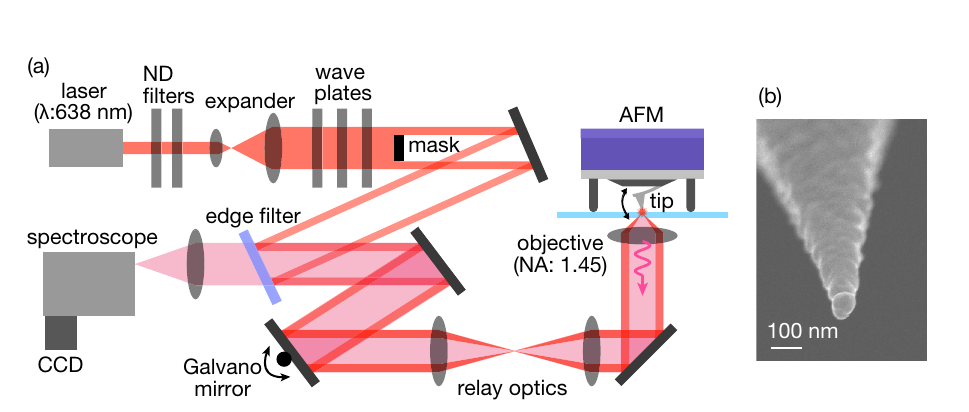
Figure 4. ( a ) Schematic of experimental setup for the tapping-mode TERS measurement. ( b ) SEM image of a metallic